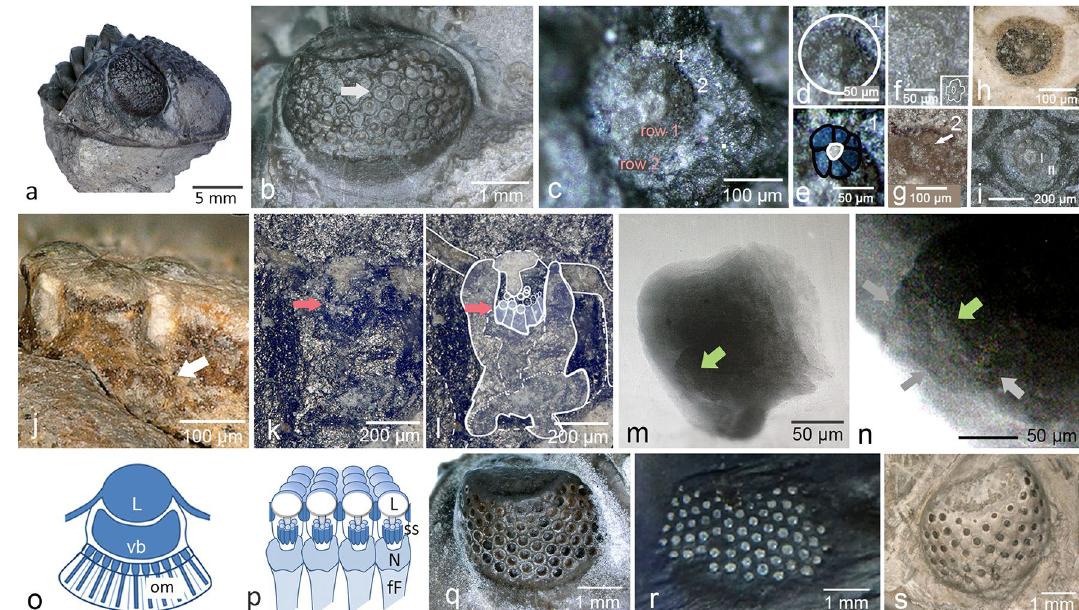
Figure 4. Structure of the visual unit of phacopid trilobites. ( a ) Cephalon of Phacops imitator Struve 1970. ( b ) Right eye of a, arrow: position of ( c ). ( c ) Ommaidial cross-section; 1,2 distinct ommatidia, see ( d , e , g ). ( d , e , g ) Cellular structure of ommatidium 1 and 2 of c, arrow indicates rhabdom). ( f ) Central element of the visual complex. ( h ) One ring of ommatidia in Geesops schlotheimi (Bronn, 1825), ( i ) two rings (I, II) of